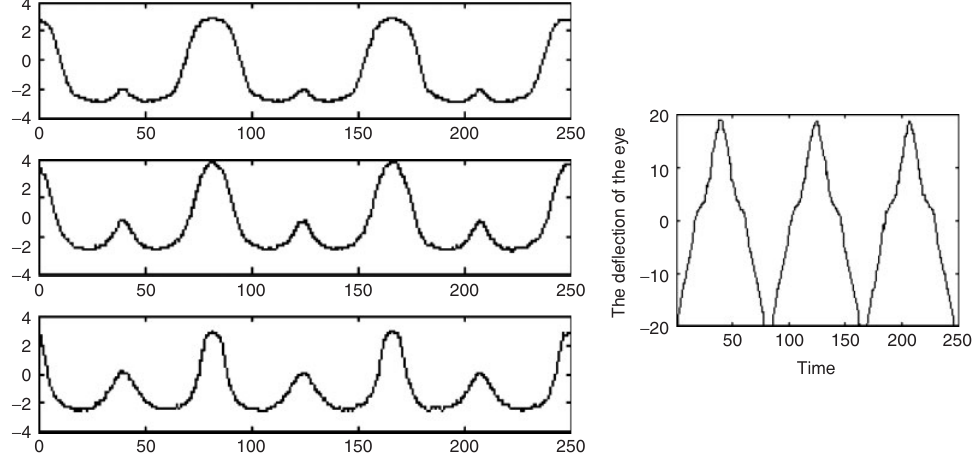
Figure 15 Fusion with fault-free